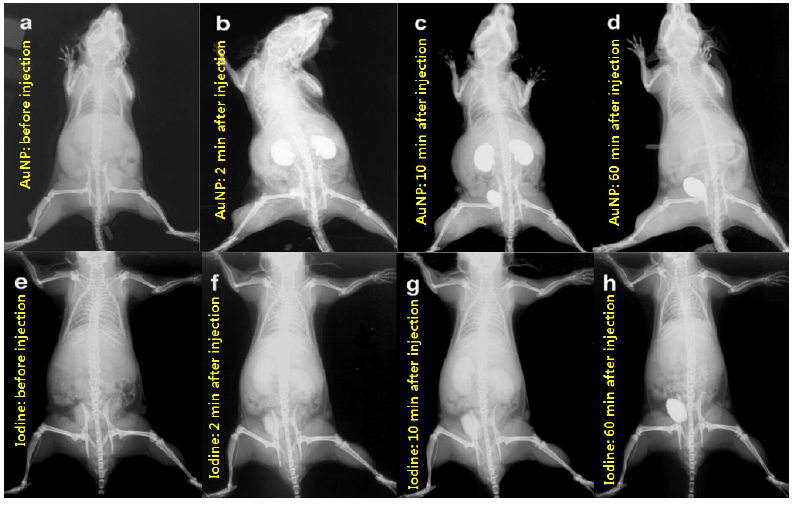
Figure 7. Pharmacokinetics of AuNPs ( a – d ) and iodine contrast agent ( e – h ) in mice. ( a , e ) Before injection. ( b , f ) 2 min after injection; ( c , g ) 10 min after injection; ( d , h ) 60 min after injection. The AuNPs show low liver and spleen uptake as well as clearance via kidneys and bladder ( b – d ). At 60 min ( d ), the contrast in the Au-injected mouse is similar to the uninjected mouse ( a ), indicating efficient clearance. A Lorad Medical Systems mammography unit (Hologic, Inc., Danbury, CT, USA; model XDA101827) is used with 8 mAs exposures (0.4 s at 22 kVp). Kodak Min-R2000 mammography film, 18 cm × 24